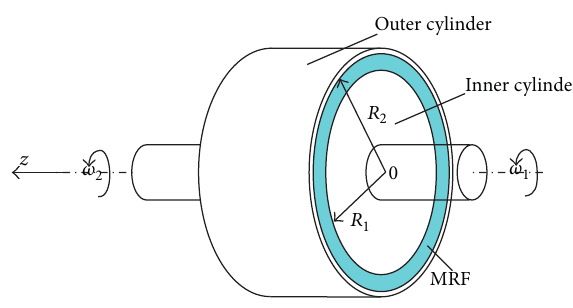
Figure 3: Circular flow of MR fluid between two